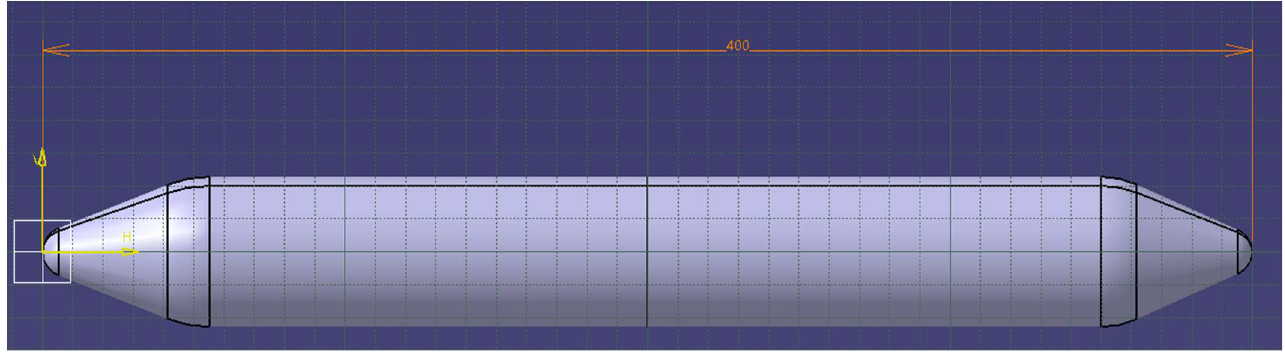
Figure 5. A typical side view of the modelled fuselage of US.